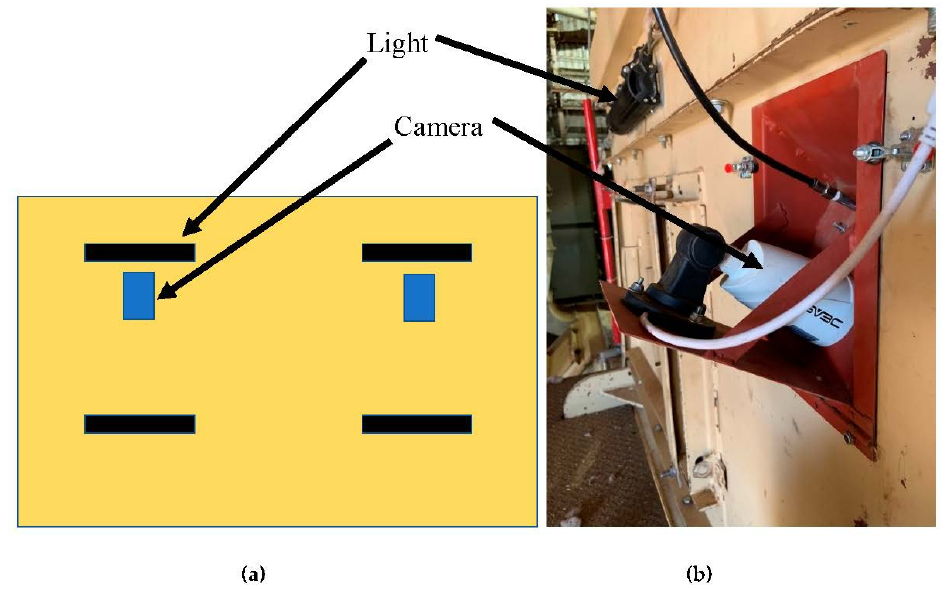
Figure 5. General placement ( a ), on back wall of module feeder, of camera inspection system components. Black boxes indicate placement of lights, blue boxes indicate placement of camera housings. Picture ( b ), shows how the camera and one of the lights were installed at a commercial gin.